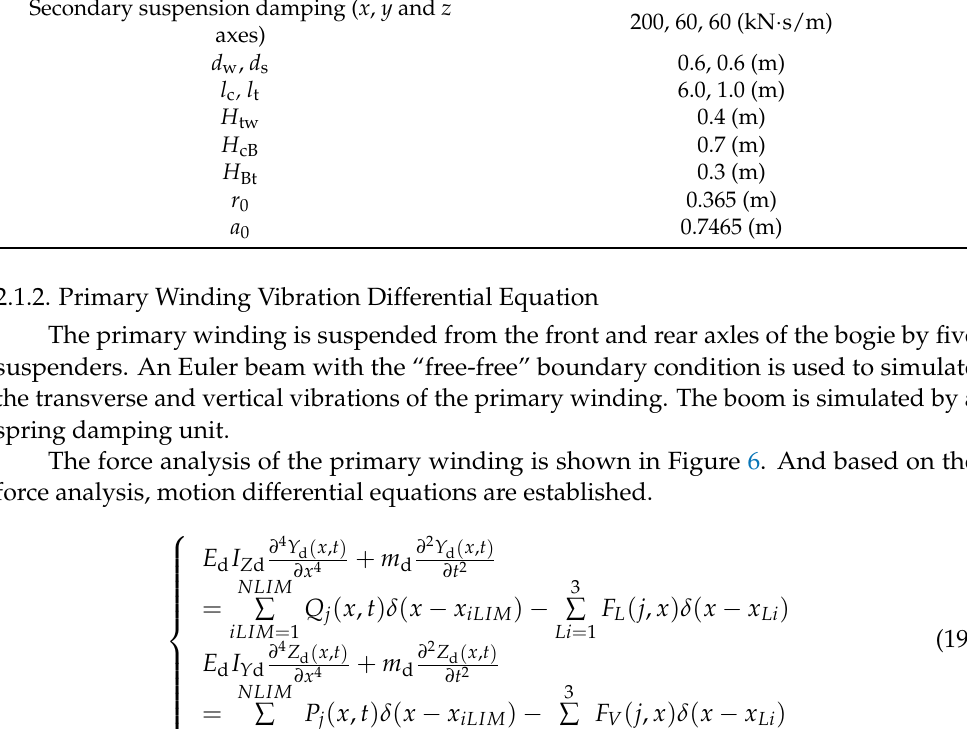
Primary suspension stiffness ( x , y and z axes) Primary suspension damping ( x, y and z axes)